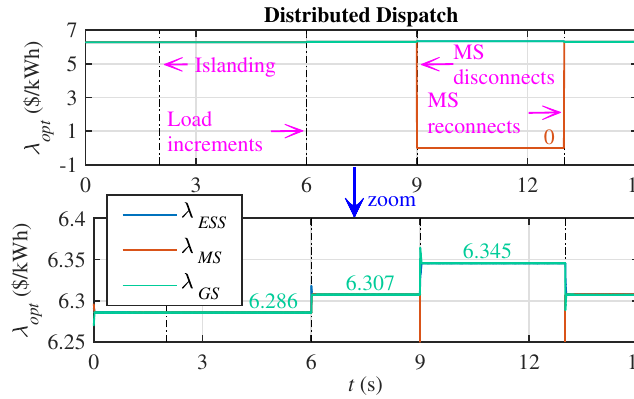
Figure 9. Incremental costs of DGUs.